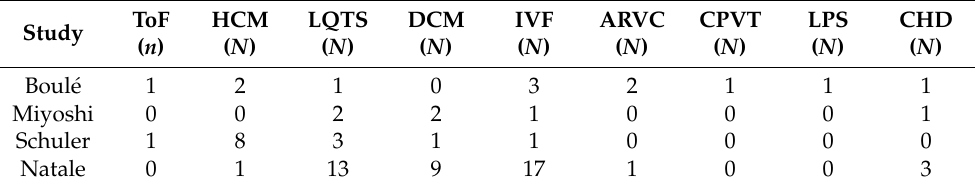
Table 4. The underlying cardiac disease for ICD